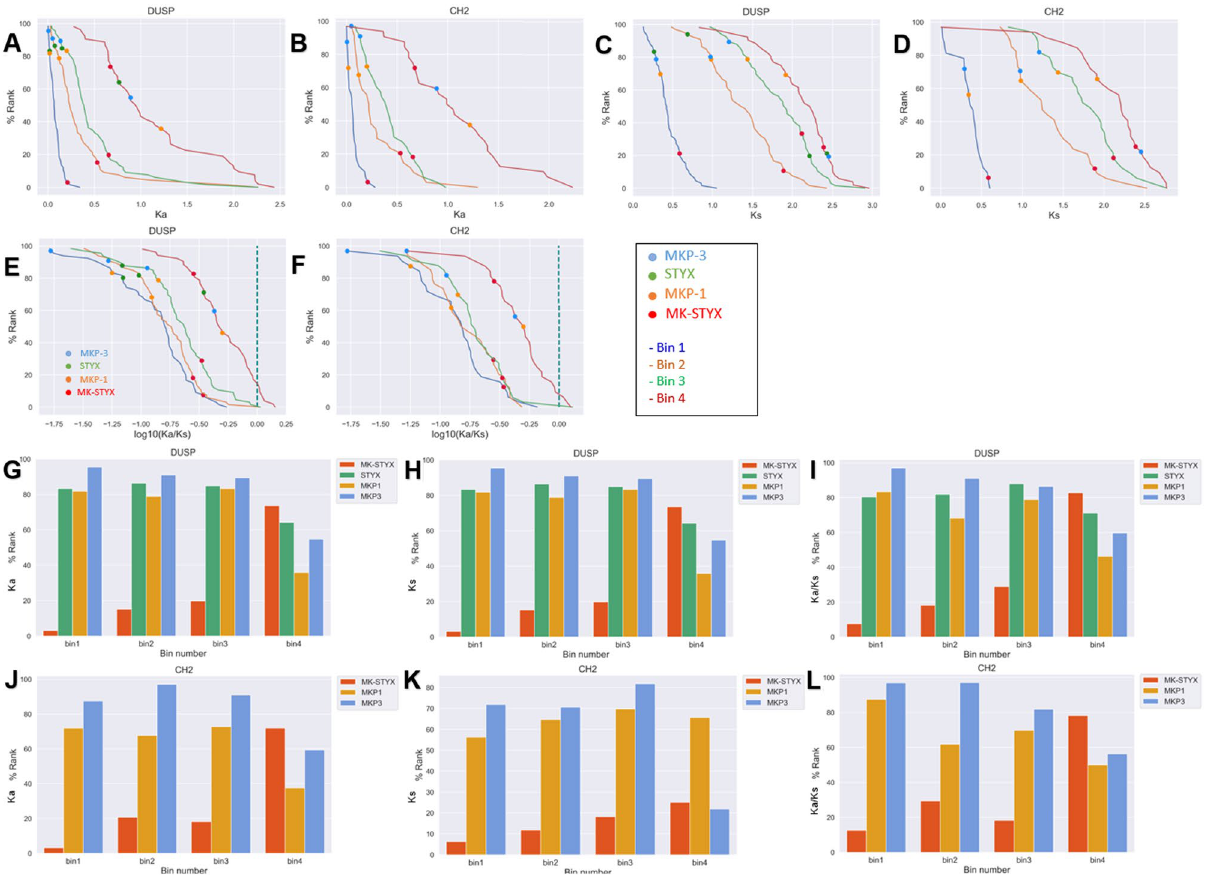
Figure 3. Ranks of median Ka, Ks, and log10(Ka/Ks) of MK-STYX, STYX, MKP-1, and MKP-3 by different models. ( A ) Cumulative probability histogram representing the median Ka of genes with the DUSP domain in the first four bins. The rank of MK-STYX is indicated by a red circle, the rank of MKP-3 is indicated by a blue circle, the rank of STYX is indicated by a green circle, and the rank of MKP-1 is indicated by an orange circle. ( B ) Cumulative probability histogram (as in A ) of the CH2 domain. ( C ) Cumulative probability histogram representing the median Ks of genes with the DUSP domain in the first four bins. The rank of MK-STYX is indicated by a red circle, the rank of MKP-3 is indicated by a blue circle, the rank of STYX is indicated by a green circle, and the rank of MKP-1 is indicated by an orange circle. ( D ) Cumulative probability histogram (as in C ) of the CH2 domain. ( E ) Cumulative probability histogram representing the median log10(Ka/Ks) of genes with the DUSP domain in the first three bins. The rank of MK-STYX is indicated by a red circle, the rank of MKP-3 is indicated by a blue circle, the rank of STYX is indicated by a green circle, and the rank of MKP-1 is indicated by an orange circle. The green dash line represents neutral selection pressure, where log 10 (Ka/ Ks) = 0 (or Ka = Ks). ( F ) Cumulative probability histogram (as in E ) of the CH2 domain. ( G ) Bar chart showing the percentile ranks of the median Ka values of MK-STYX, STYX, MKP-1, and MKP-3 in the three bins of the DUSP group. (H) Bar chart (as in G ) showing the ranks of the median Ks values. ( I ) Bar chart (as in G ) showing the ranks of the median log 10 (Ka/Ks) values. ( J ) Bar chart showing the percentile ranks of the median Ka values of MK-STYX, MKP-1, and MKP-3 in the three bins of the CH2 group. ( K ) Bar chart (as in J ) showing the ranks of the median Ks values. ( L ) Bar chart (as in J ) showing the ranks of the median log 10 (Ka/Ks) values. Python (Core Team 2015; https:// www. python. org.) packages Matplotlib (version2.2.2; https:// doi. org/ 10. 5281/ zenodo. 12020 77) and Seaborn 57 were used to plot and analyze data. The layout was designed in Microsoft 99-mer nucleotide regions on the full alignments of MK-STYX, STYX, MKP-1, and MKP-3; every 99-mer win- dow was 9 base pair apart from the proceeding one. Then the Ka and Ks values of all the windows of the four genes of interests were calculated. The regional values of the Ka/Ks ratios (per 99-bp ‘windows’) are plotted in an ‘iceberg’ graph for MKP-1, MKP-3, STYX, and MK-STYX (Fig. 4A–D respectively). The active homologs display similar patterns in their CH2 and DUSP domains. For MKP-1 and MKP-3, the DUSP domains are under stronger purifying selection pressure than the CH2 domains. There is a negative spike in regions that contain the KIM of both proteins, and the regions with the active sites is one of the most conserved regions (Fig. 4A,B). In comparison, selection pressure on the CH2 and DUSP domain of MK-STYX are nearly neutral, without any distinguishable pattern (Fig. 4D). While the DUSP domain of STYX is under similar selection pressure as MKP- 1, its active site is much more neutral than the active phosphatase (Fig. 4C). However, the active site of STYX